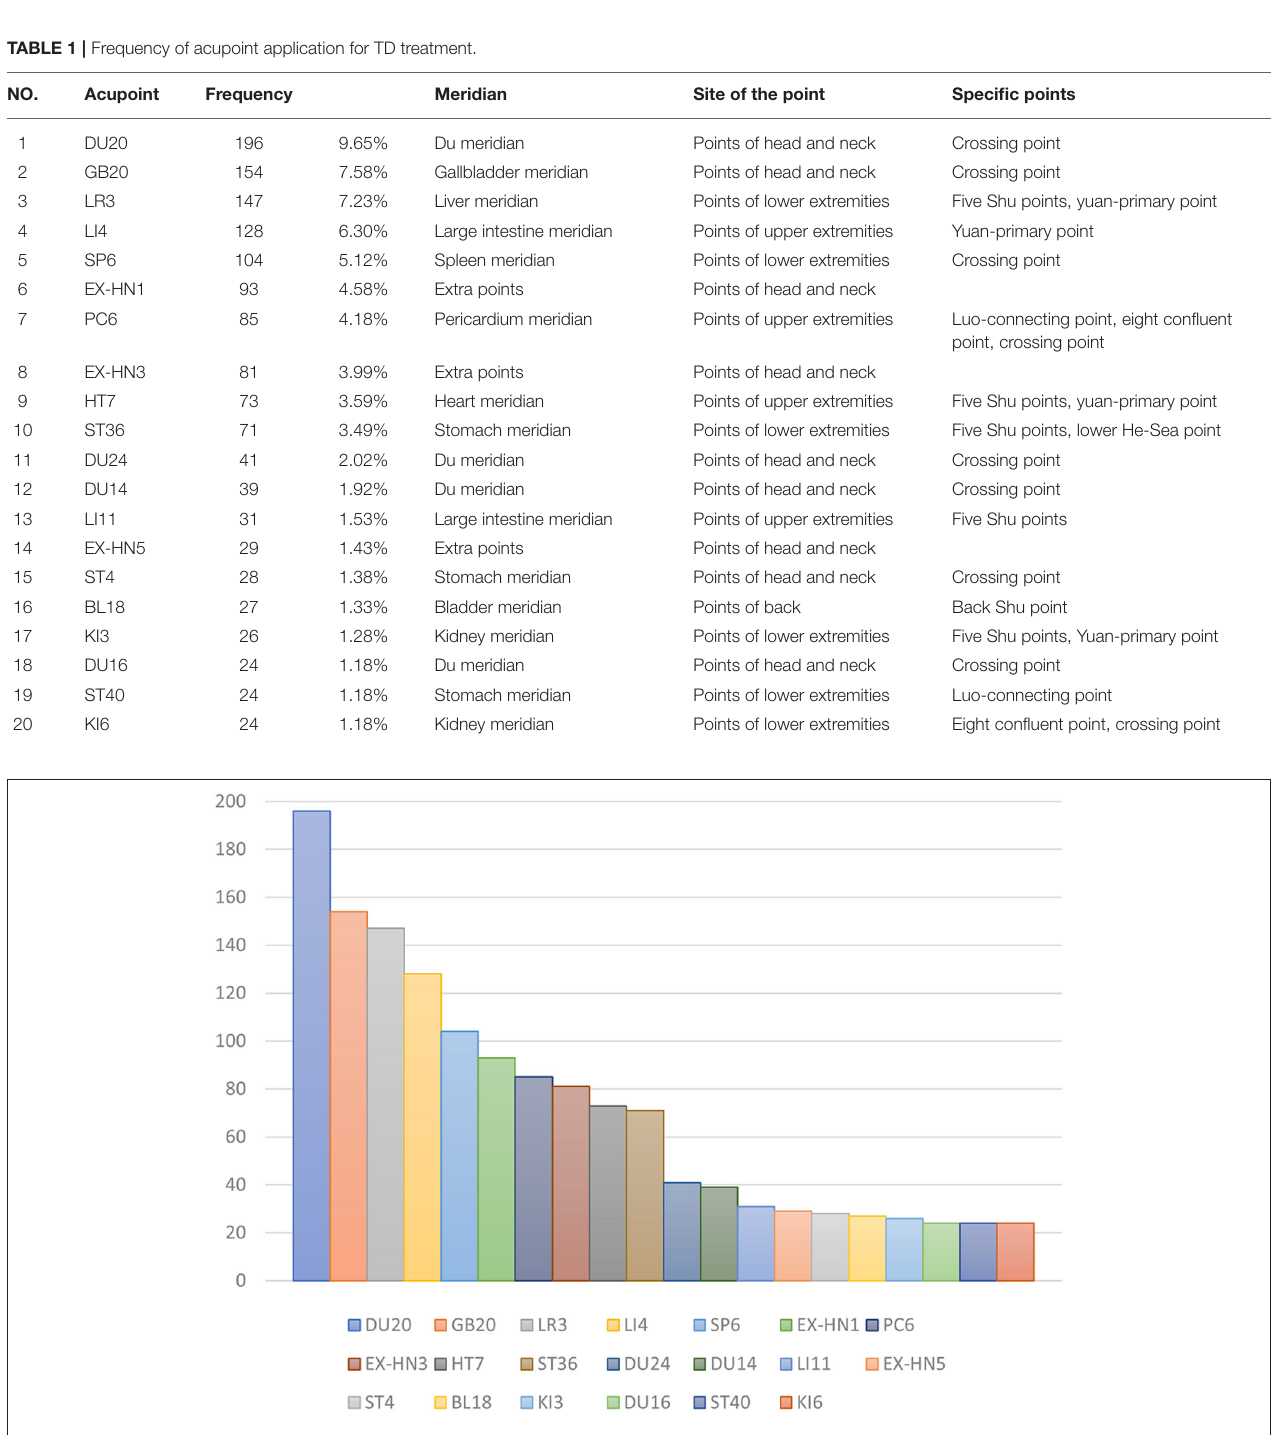
FIGURE 3 | Frequency of acupoint application for TD treatment.